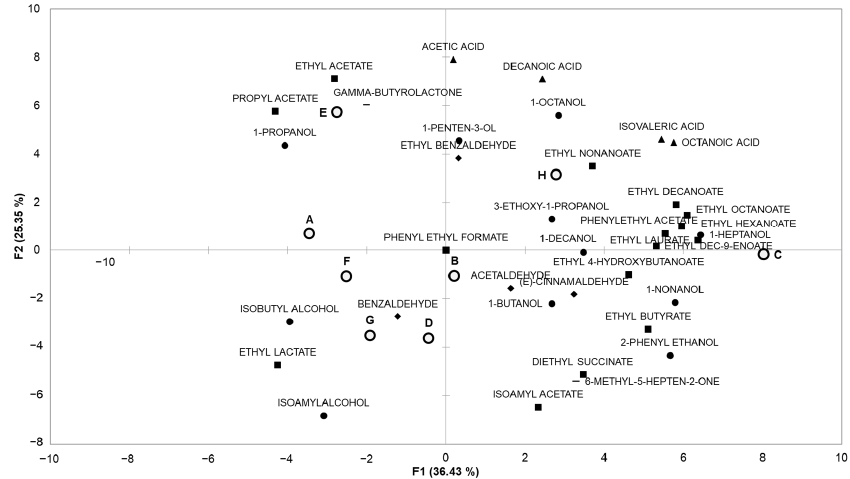
Figure 3. Principal component analysis (PCA) based on volatile compounds present in the final medium after fermentation in conditions A to H. The compounds are represented as followed: ● alcohols; ◆ aldehydes; ▲ carboxylic acids; ▬ ketones; ■ esters. Axis F1 marks a separation between four groups: condition E, which is close to ɣ - butyrolactone and esters with short chains; condition H, which is closer to carboxylic acids; conditions G and D, which are close to benzaldehyde (conditions corresponding to the predominance of Lt throughout the fermentation); and the other conditions.